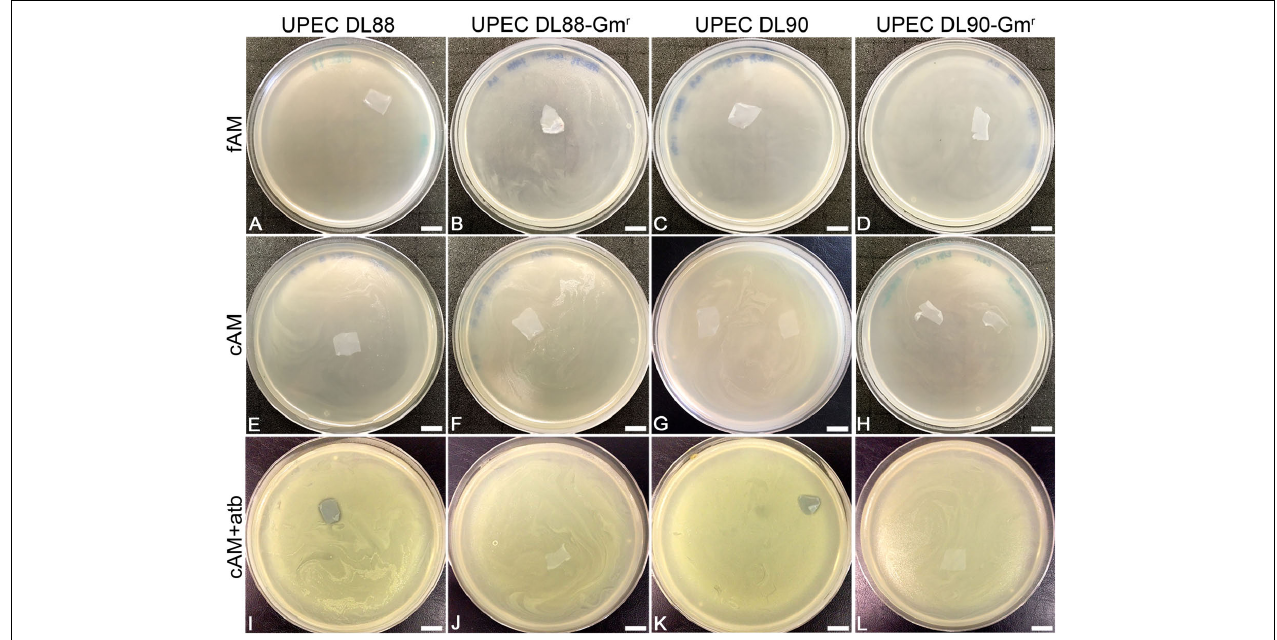
FIGURE 2 | The antimicrobial effect of fresh (fAM), cryopreserved (cAM) and cAM + atb patches on UPEC DL88 and UPEC90 and gentamicin-resistant UPEC strains (UPEC DL88-Gm r , UPEC DL90-Gm r ). fAM (A–D) and cAM (E–H) patches have no antimicrobial effect on UPEC strains and gentamicin-resistant UPEC strains. cAM + atb patches have antimicrobial effect on (I) UPEC DL88 and (K) UPEC DL90 strains, however, they have no antimicrobial effect on (J) UPEC DL88-Gm r and (L) UPEC DL90-Gm r strains. These results were obtained by employing antimicrobial efficiency assay with AM patches embedded in soft agar. Three independent replications of experiments using three biological samples were conducted and three technical repeats were performed for each condition. Scale bars: 10 mm.